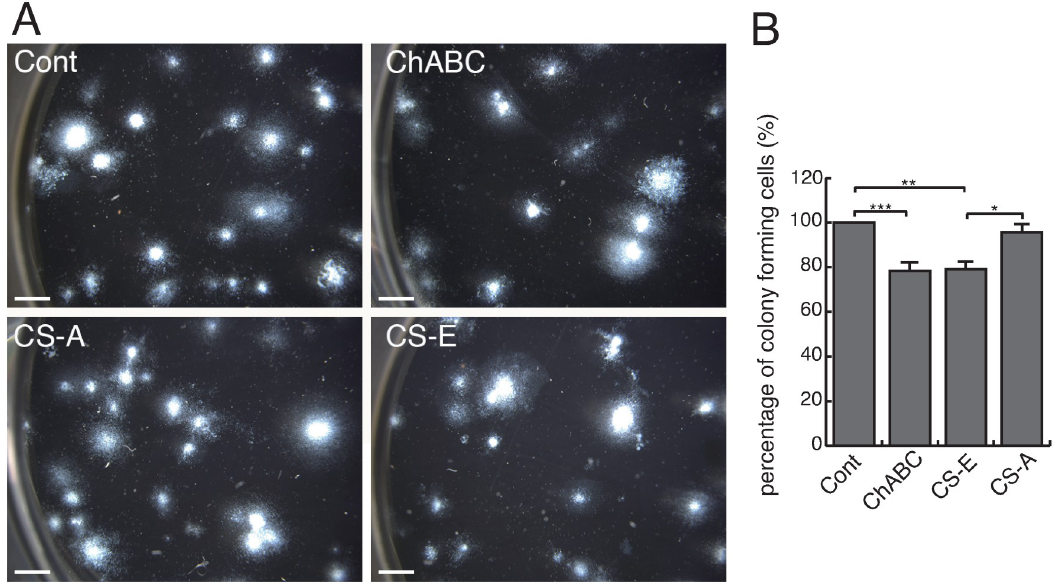
Fig 5. Effect of CS/DS in the CFU-GM assay. (A) Representative photographs of the CFU-GM assay in the control (Cont), in culture with Chase ABC (ChABC), with CS-A, or with CS-E. Bar, 2 mm. (B) The percentage of colony-forming cells. Data are expressed as means ± SEM. � p < 0.05, �� p < 0.01, ��� p < 0.001. (control, n = 4; ChABC, n = 4; CS-A, n = 3; CS-E, n =